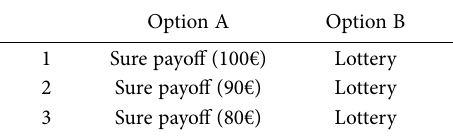
Figure 1. Example of a choice list for experiment 1 (risk attitude) and 2 (ambiguity